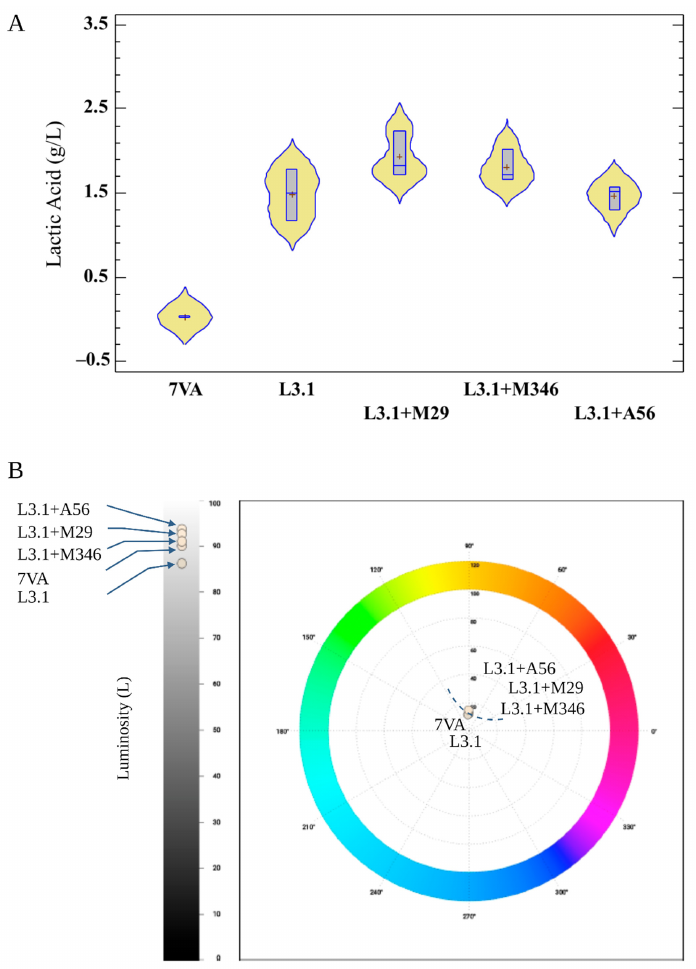
Figure 3. ( A ) Violin chart for the accumulation of lactic acid (g/L) in the different fermentations. Different letters indicate significant difference between means ( p < 0.05). ( B ) Comparison of wines in terms of chromatic parameters and